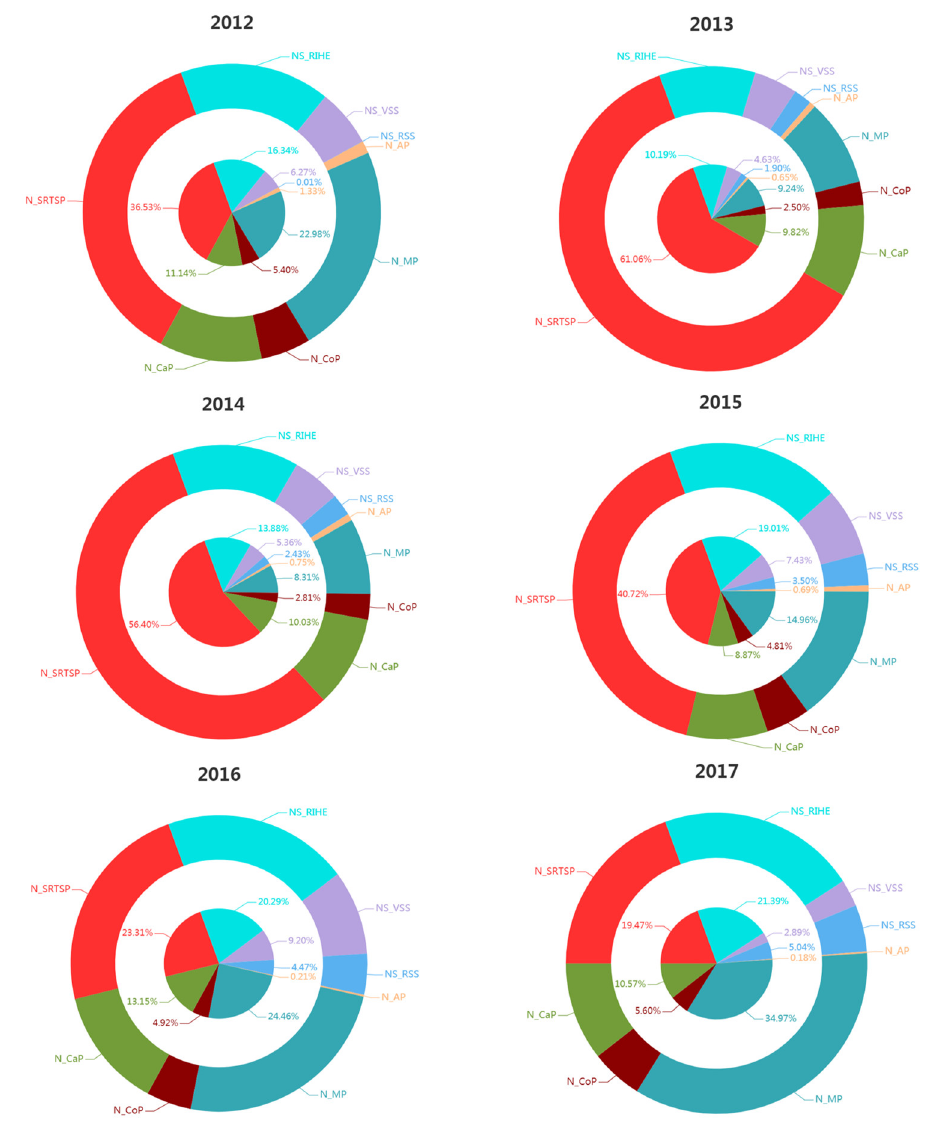
Figure 4. Relative importance of evaluation variables. (All of the variables are the number of people